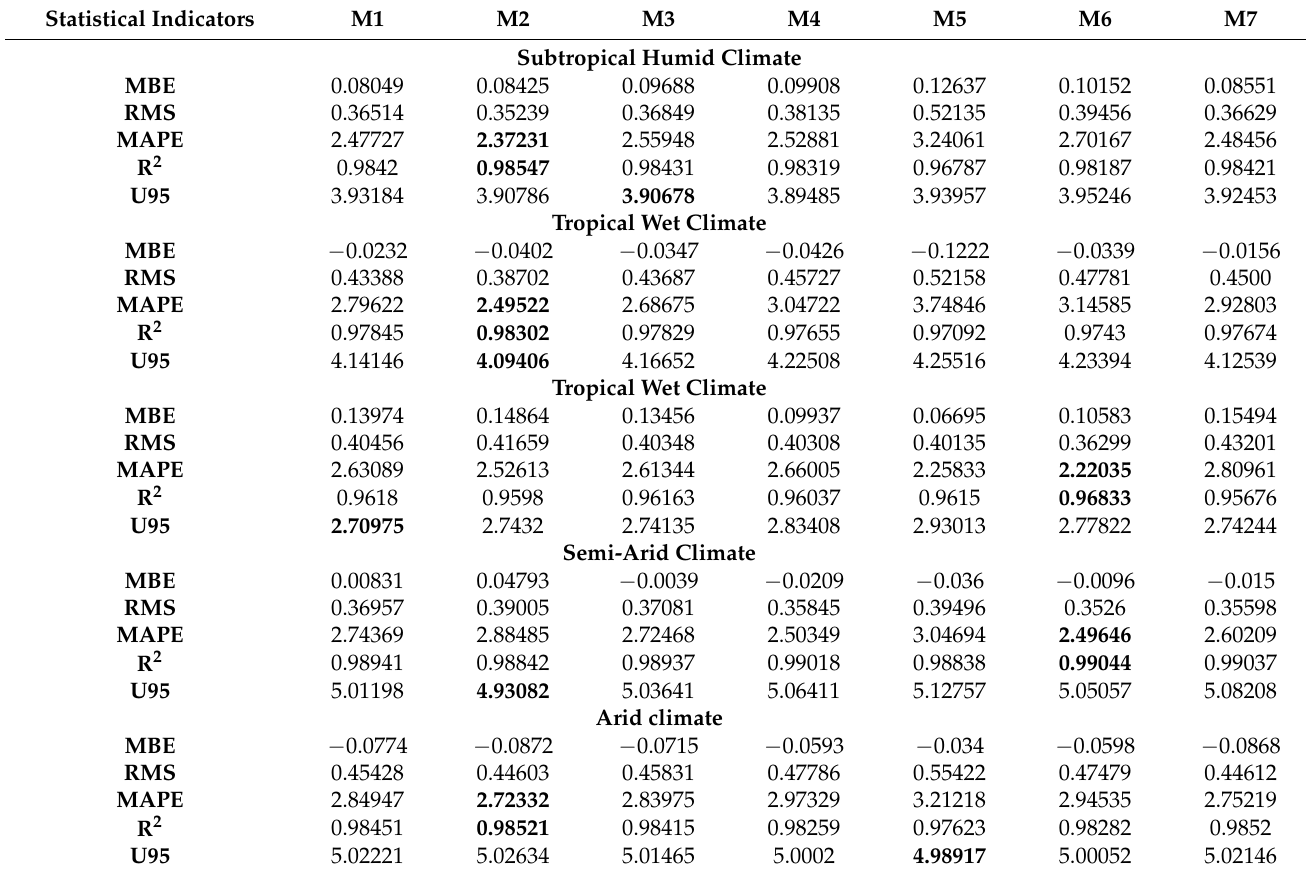
Table 5. Statistical indicator values for Category-2 ML models for different climatic